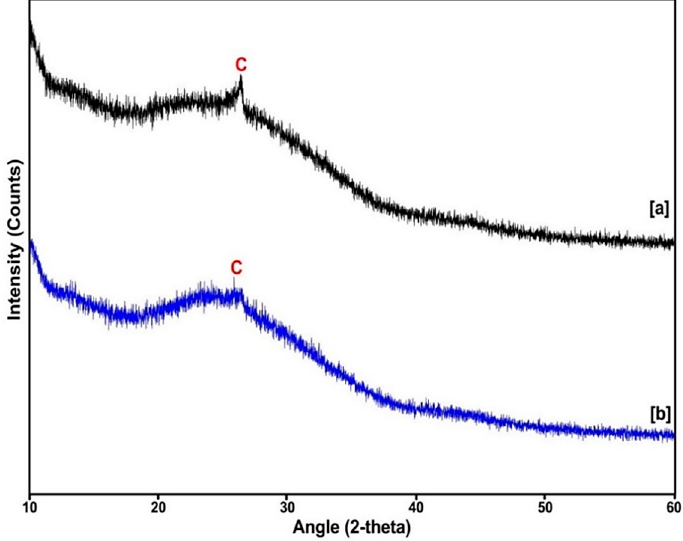
Int . J . Mol . Sci . 2020 , 21, x FOR PEER REVIEW Figure 3. The XRD pattern of ( a ) SWCNTs and ( b ) SWCNTs-HA-Ce6. Figure 3. The XRD pattern of ( a ) SWCNTs and ( b ) SWCNTs-HA-Ce6.